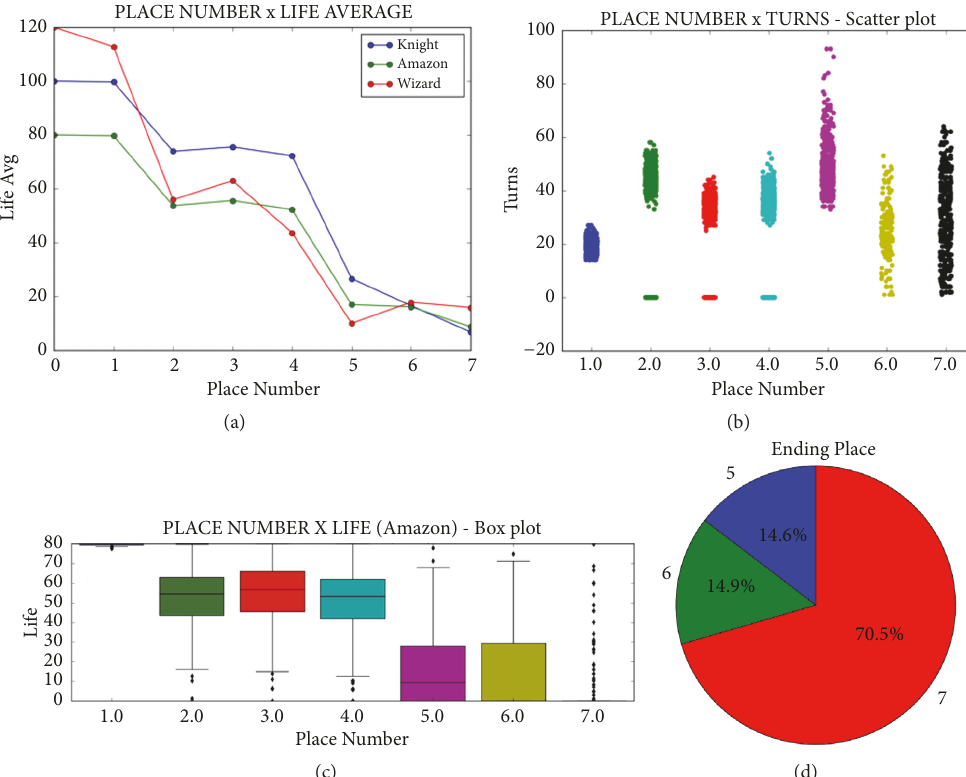
Figure 8: Simulation results from the first iteration: (a) average life at each place, (b) number of turns at each place, (c) life of the Amazon Hero at each place, and (d) place where simulation ended.